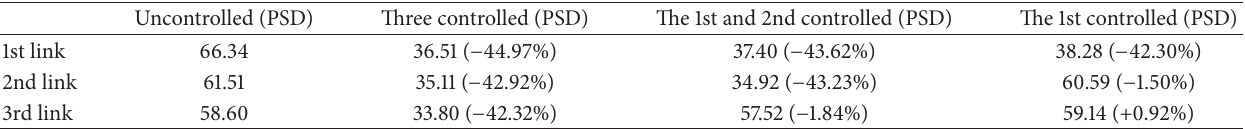
Table 1: The summarized results of the three comparison